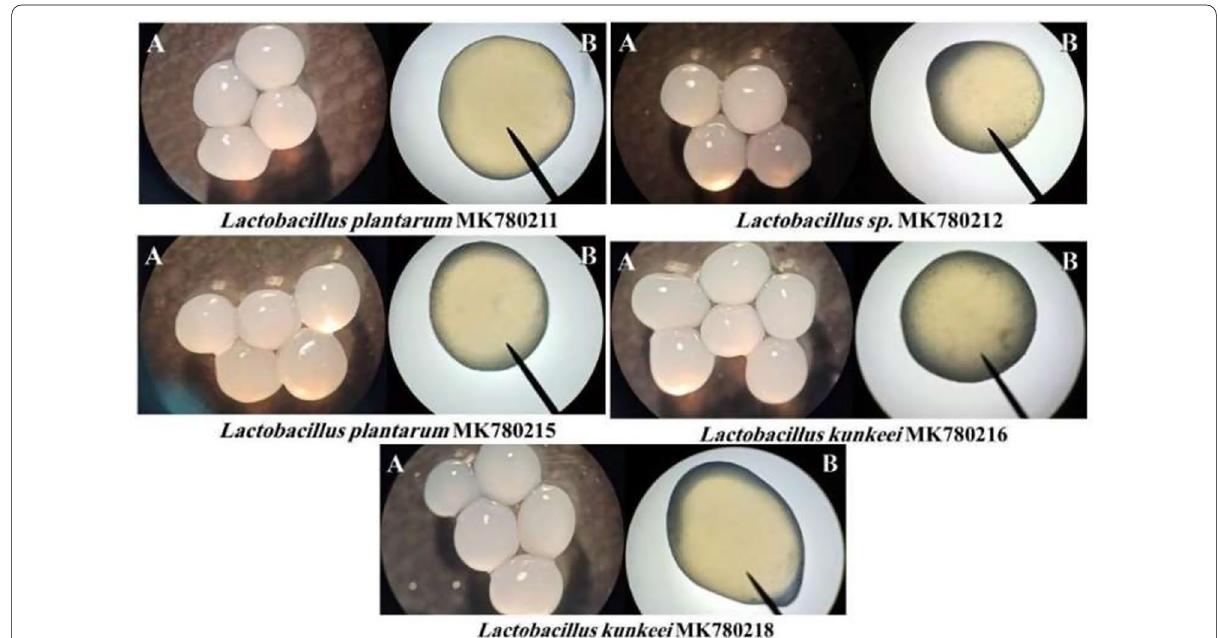
Fig. 1 Double-coated microcapsules loaded with the five LAB. A Capsules with magnification power 4 magnification of 40 10. ×